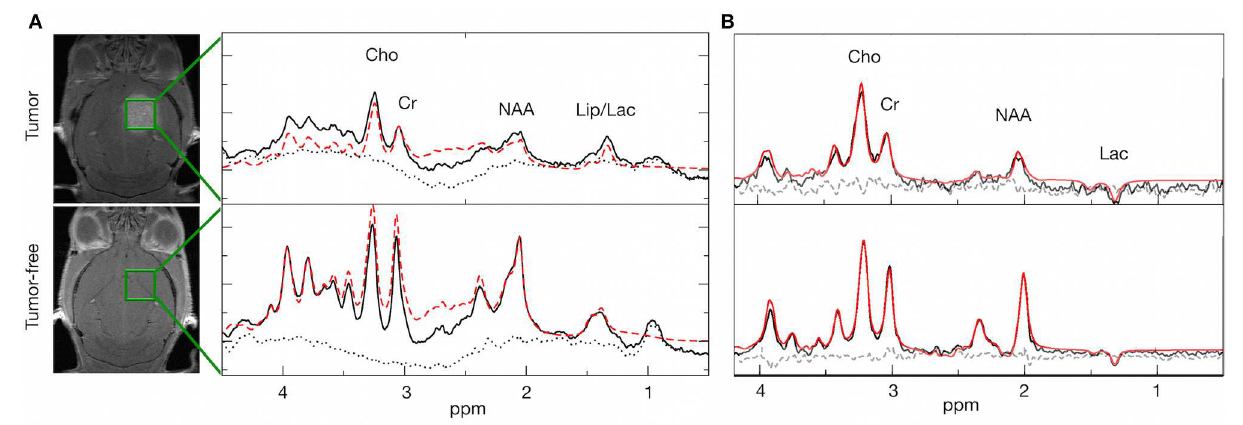
FIGURE 4 | Spectral changes in response to tumor progression and radiotherapy. (A) Representative spectra of a tumor bearing and a tumor-free mouse with peaks for Cho (3.20 ppm), Cr (3.03 ppm), NAA (2.01 ppm), and Lac (1.33 ppm) + Lipids at short echo time (16.5ms). (B) Representative spectra of a tumor bearing and a tumor-free mouse with peaks for Cho (3.20 ppm), Cr (3.03 ppm), NAA (2.01 ppm), and Lac (1.33 ppm) at long echo time (135ms). Black line: original spectrum, red (dashed) line: spectral fit, black dotted line: residual data. Representative MR images depict the localization of the